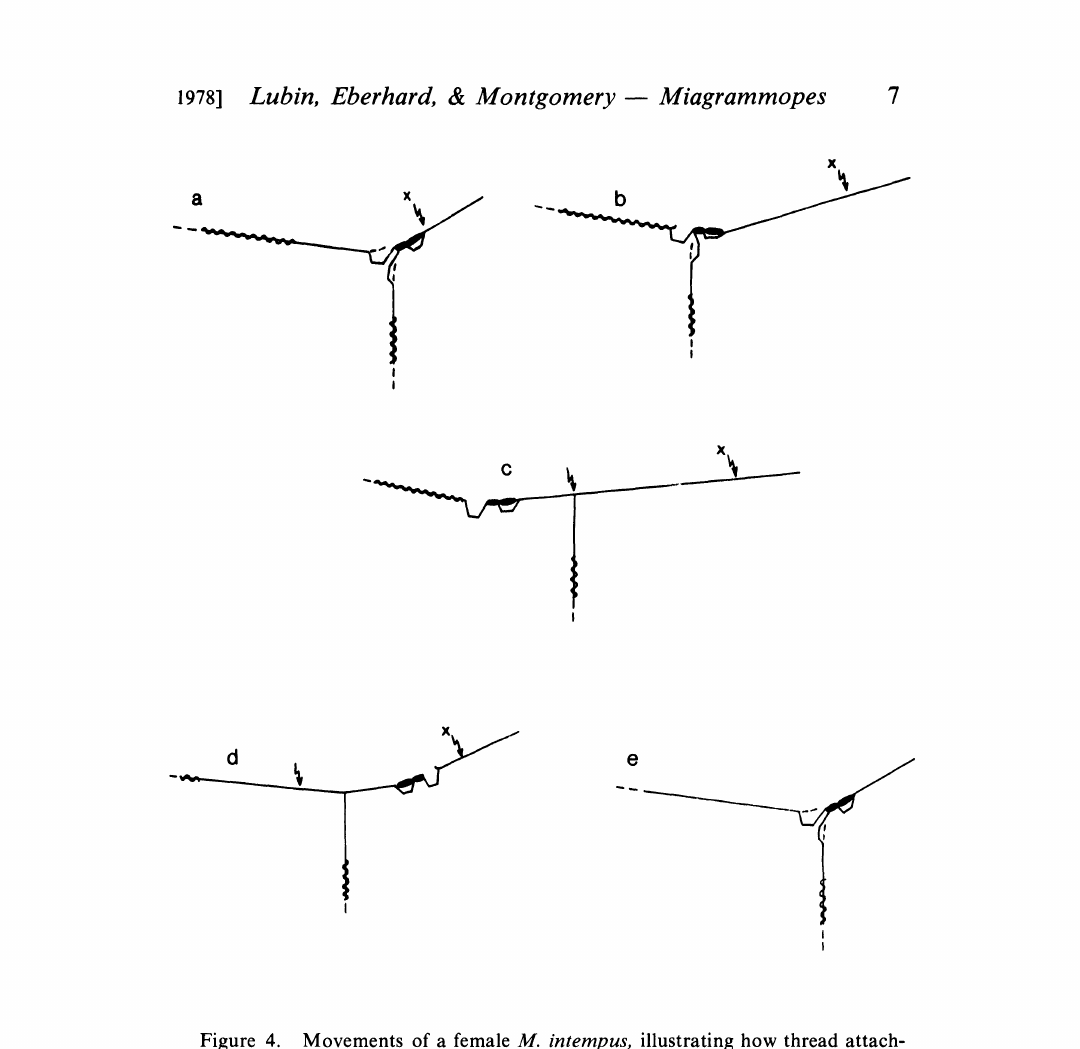
Figure 4. Movements of a female M. intempus, illustrating how thread attach- ments are manipulated. Letters mark spots on horizontal thread. The spider rested (a) holding both sticky lines with its front legs, and a third, short, non-sticky line with its hind legs at point x (the ends of the capture threads were not drawn as they could not be seen). When lured out onto the horizontal sticky line, the spider car- ried the vertical thread for some distance (b), then attached it to the horizontal line and continued on (c). When she returned, she shifted the point of attachment of the vertical thread again (d), then turned around and pulled in the line with her front legs and resumed her original position (e). The shifts in attachment were extremely rapid; the actual motions involved could not be followed, and the shifts were noticed only by comparing thread positions before and after the spider passed